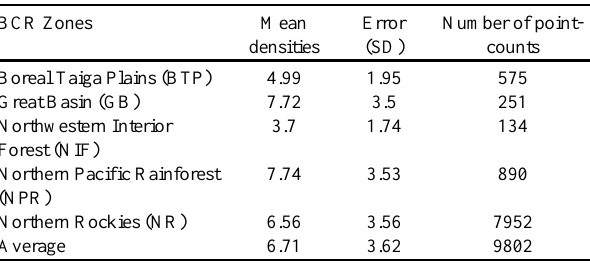
Table 2 . Estimated mean passerine densities (total passerines/ ha) in each Bird Conservation Region (BCR) zone for British Columbia based on ~6100 point-counts conducted in British Columbia from 2000-2008. Species such as Brown-headed Cowbirds ( Molothrus ater ), that do not construct nests, and cliff- or bank-nesting species, with nests unlikely to be destroyed by forestry activities, were not included in these